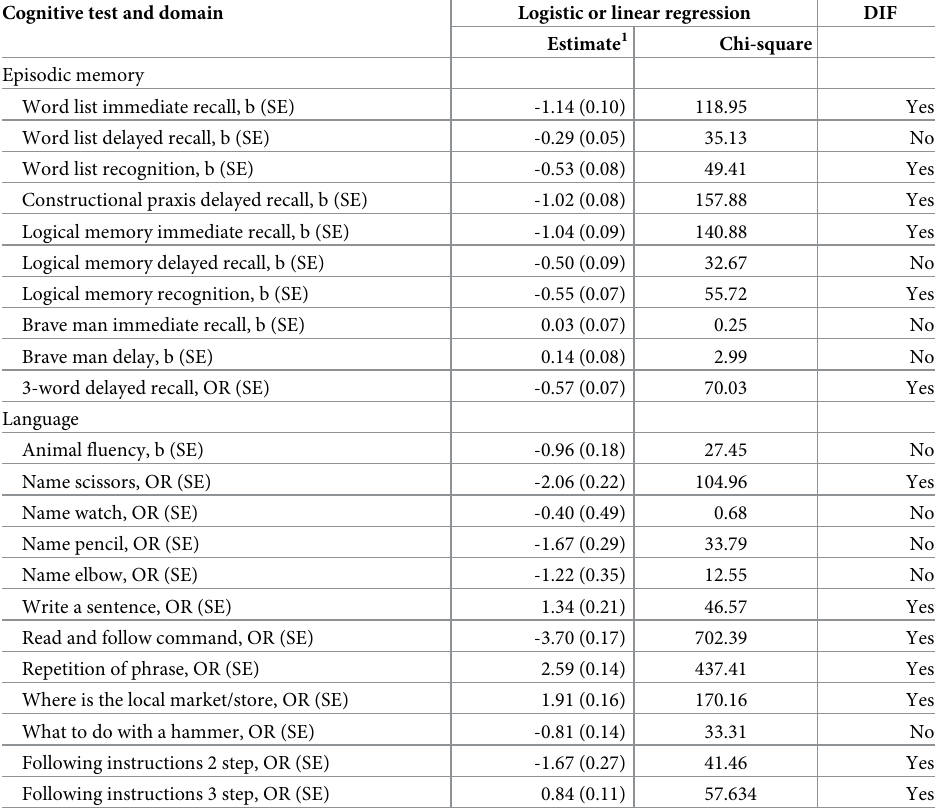
Table 4. DIF detection using logistic and linear regression. Cognitive test and